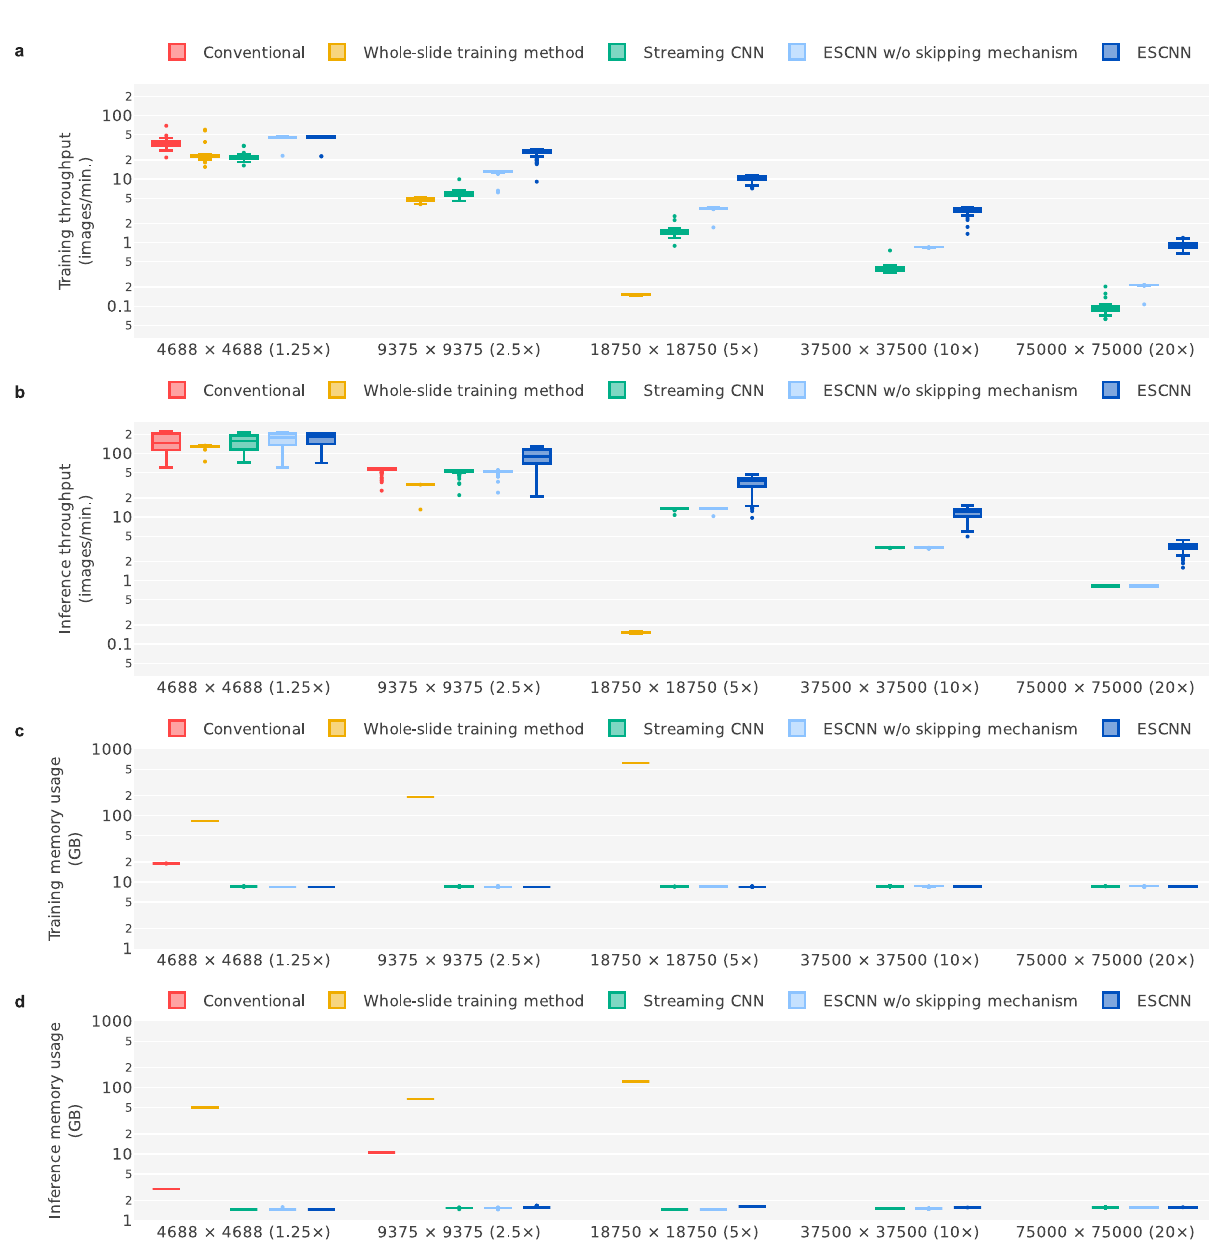
Fig. 3 Throughput and memory consumption of end-to-end training methods under various magni fi cation levels of LN images. Each panel represents the ( a ) training throughput, ( b ) inference throughput, ( c ) training memory consumption (referring to Uni fi ed Memory for the whole-slide training method and GPU memory for the others), and ( d ) inference memory consumption. For each setting, we recorded the training/inference time and memory consumption when processing each LN image ( n = 100 images in total, sampled from the main training set). Each box-and-whisker plot comprises the center (median), the bounds of boxes (Q1 and Q3), the bounds of whiskers (the minimum and maximum within the range, obtained by adding the median to ±1.5 times the Q3 – Q1 distance), and the outliers of the underlying 100 samples. The absence of certain boxes indicates that those settings could not be run due to memory